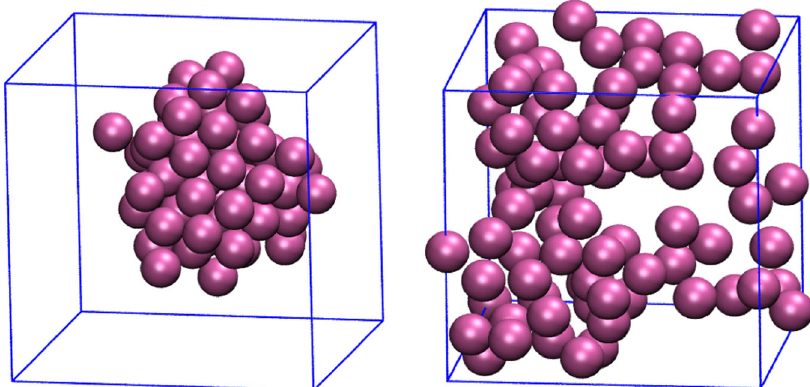
Fig. 1 Snapshots of a NP phase for q = 0.6 showing a crystal and a disordered phase as discussed in the text. M = 10 and η c = 0.1